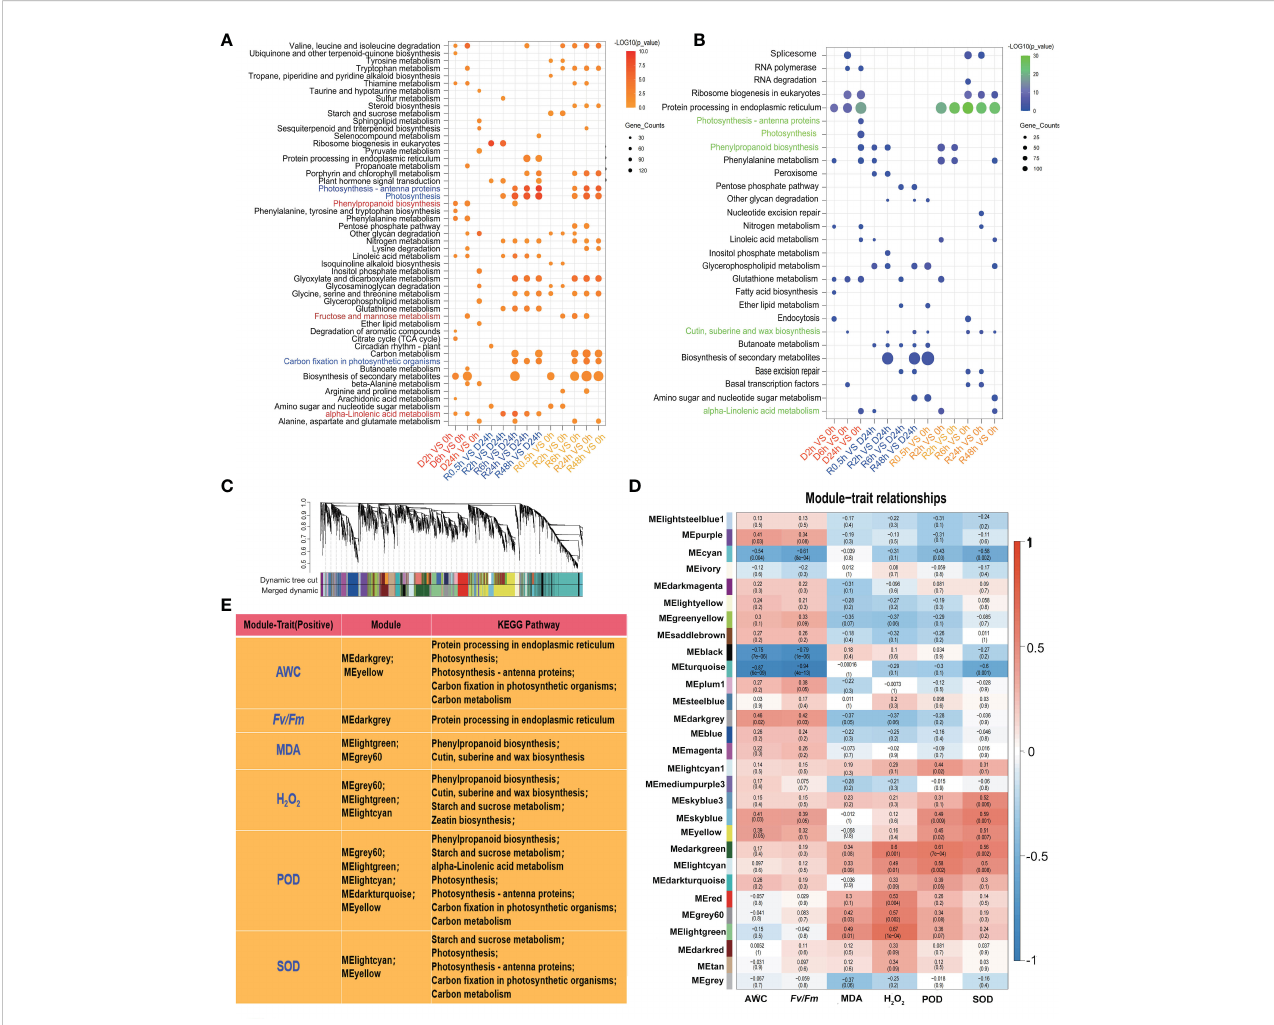
FIGURE 4 KEGG analysis and identi fi cation of modules related with the traits during D-R treatment in S. caninervis. (A) KEGG analysis of up-regulated DETs; Dots indicate the KEGG pathway with signi fi cant difference, and color indicates the degree of signi fi cance (From orange to red, the higher the signi fi cance) and the size of the circle indicates the number of transcripts. (B) KEGG analysis of down-regulated DETs; Dots indicate the KEGG pathway with signi fi cant difference, and color indicates the degree of signi fi cance (From blue to green, the higher the signi fi cance) and the size of the circle indicates the number of transcripts. (C) Transcripts dendrogram with cluster. Each module was assigned different colors. (D) Module-trait relationships. Each row corresponds to a colour module and column corresponds to a trait (AWC, Fv/Fm , MDA, H 2 O 2 , POD, SOD). Each block contains the correlation value and p ≤ p -value; (E) KEGG analysis for screening positive correlation module with traits (AWC, Fv/Fm , MDA, H 2 O 2 , POD, SOD) and